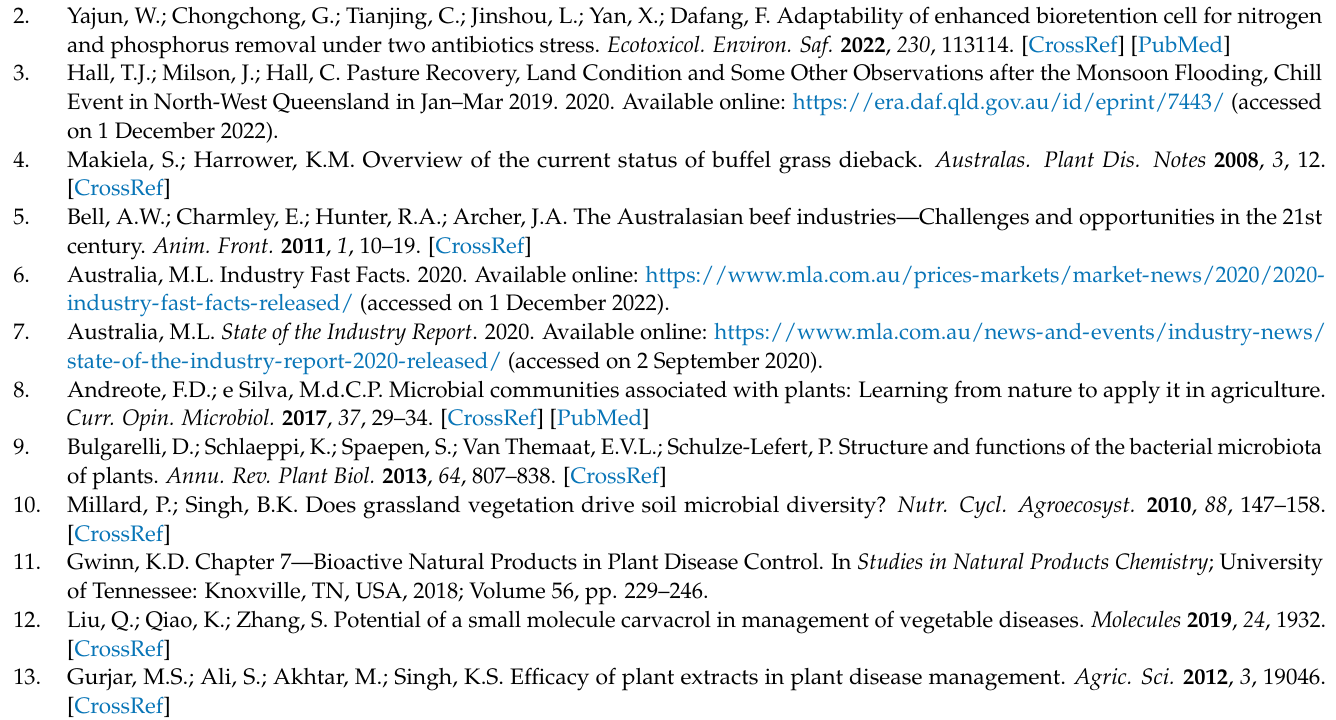
Figure S5: Morphometric measurements in monocot six months after treatment; Figure S6: Dry matter differences between healthy, phytogenic liquid-treated, and control plots. Data from the second trial; Figure S7: Grass/dicots ratio among healthy, phytogenic liquid-treated, and pasture dieback